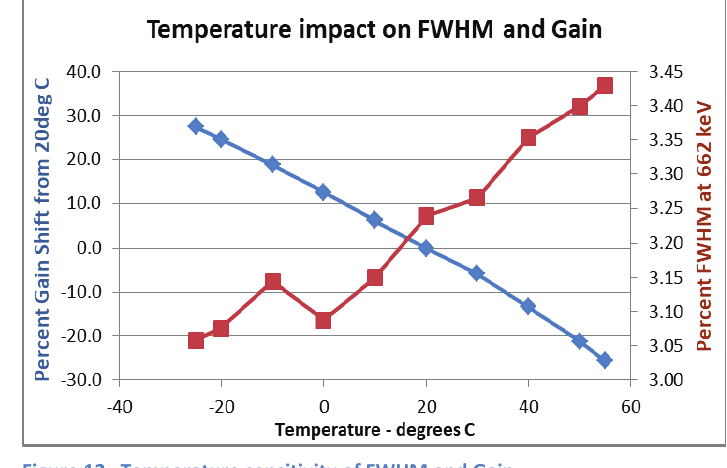
Figure 12 Temperature sensitivity of FWHM and